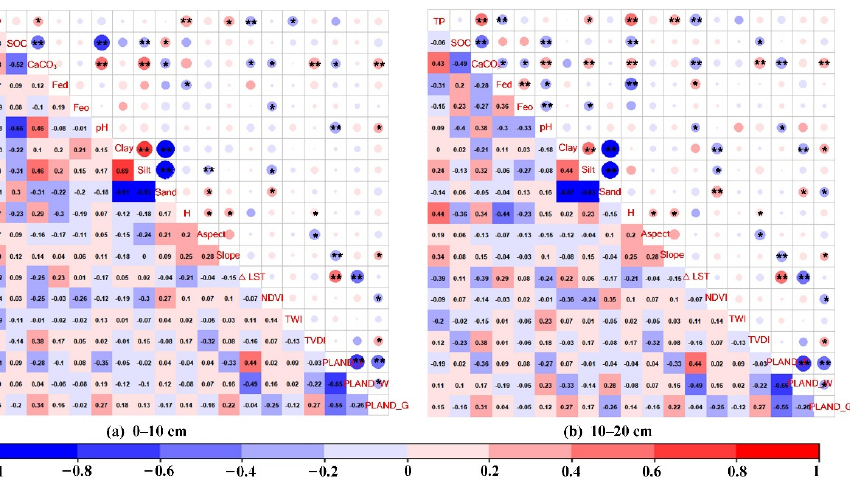
Figure 2. Heat map of the correlation matrix of the independent variables used in the PLSR analysis in the Zhifanggou watershed: ( a ) 0–10 cm; ( b ) 10–20 cm. TP, total porosity; SOC, soil organic carbon; CaCO 3 , calcium carbonate; Fe d , free iron; Fe o , amorphous iron; Clay, clay content; Silt, silt content; Sand, sand content; H, elevation; Δ LST, the land surface temperature difference between seasons; NDVI, normalized difference vegetation index; TWI, topographic wetness index; TVDI, temperature vegetation dryness index; PLAND_F, PLAND_W, and PLAND_G, the proportion of the landscape occupied by farmland, woodland, and grassland, respectively. * Correlation is significant at the 0.05 level (2-tailed); ** Correlation is significant at the 0.01 level (2-tailed). Then, PLSR was used to identify the key factors and their magnitudes of influence in controlling the aggregate stability. It generalizes and combines features from PCA and multiple regression (MR). Further information on PLSR is described by Carrascal et al. [9]. SIMCA-P + 13.0 (Umetrics AB, Sweden) was used to perform the PLSR. The cross-valida- tion was used to finalize the appropriate number of components to overcome overfitting.